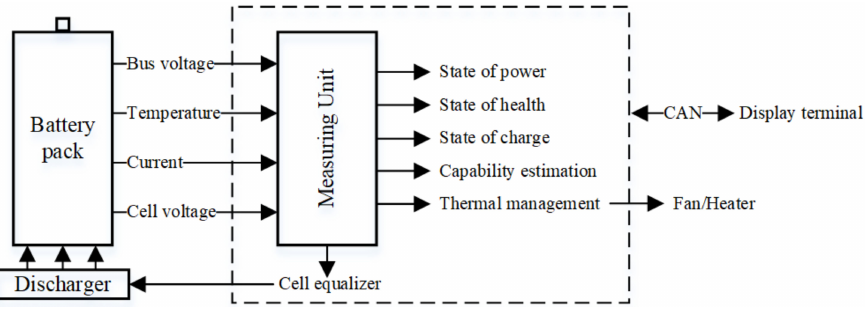
Figure 4. General diagram of a